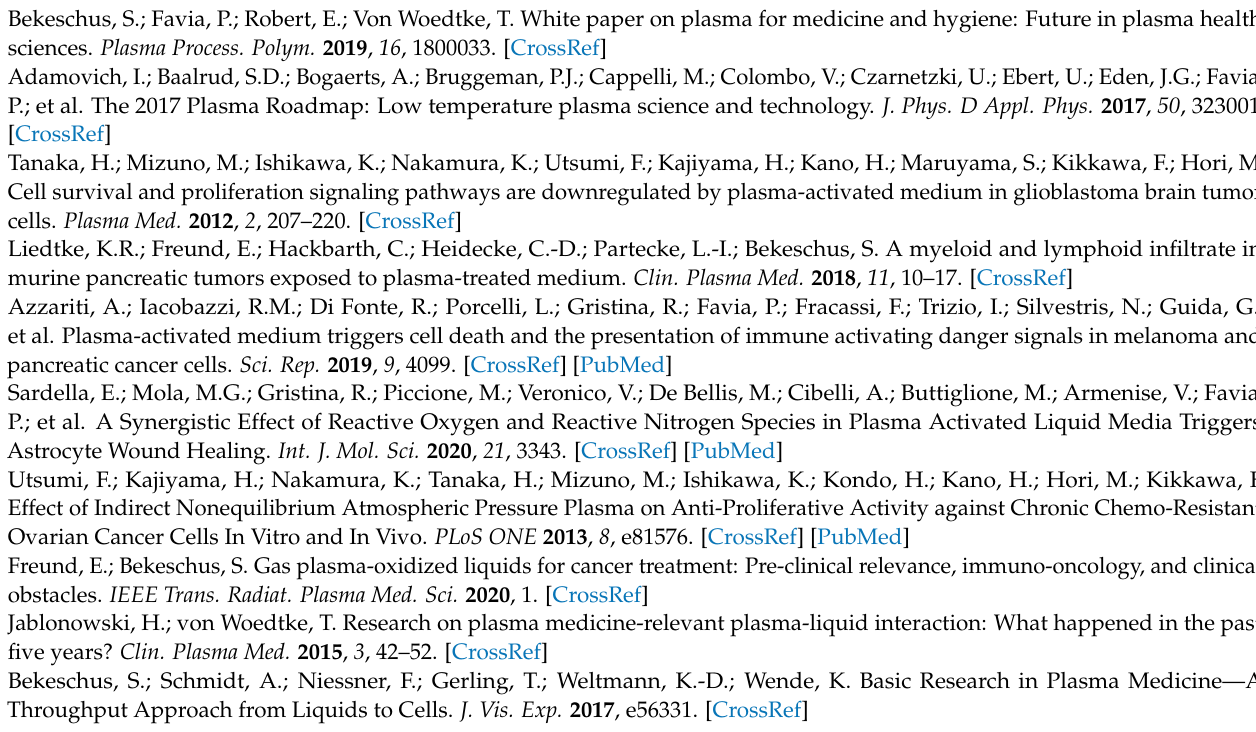
ratio; Figure S4: EPR spectra and fluorescence spectra of PT-DMEM with and without the serum; Figure S5: Coomassie blue stained Saos2 cells 48 h after incubation in 300 µ M H 2 O 2 solution in DMEM compared with the